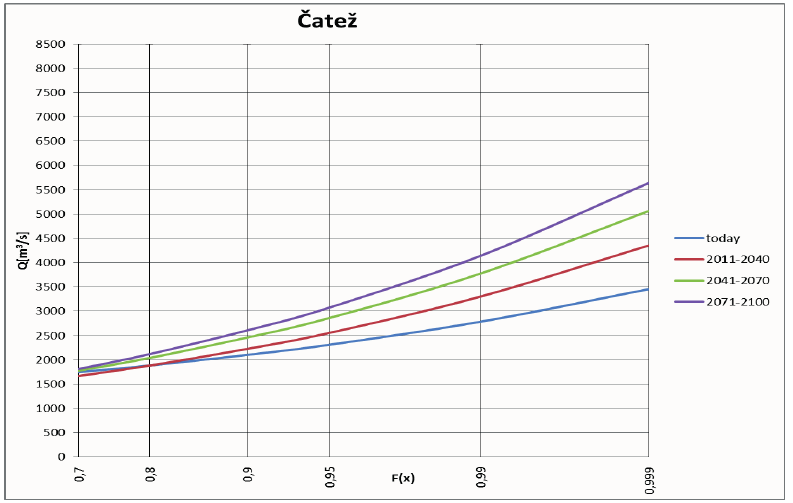
Fig. 2 Climate change impacts on probability curves of Water Station Čatež on the Sava River